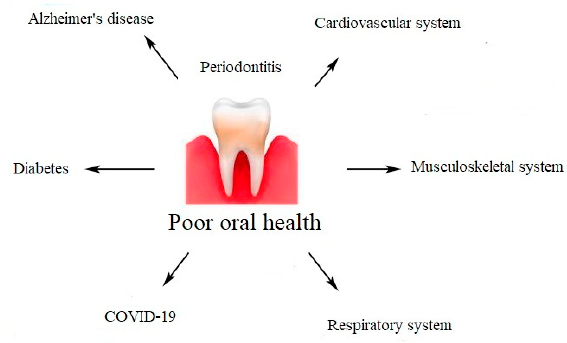
Figure 2. Impact of poor oral health on systemic diseases.